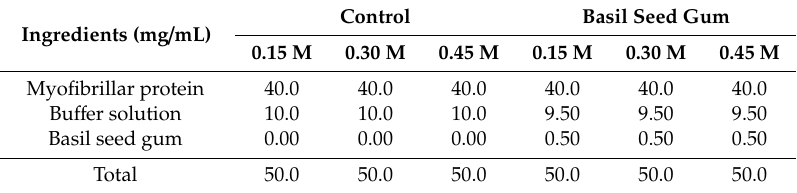
Table 1. Formulation of myofibrillar protein gels with basil seed gum at di ff erent salt